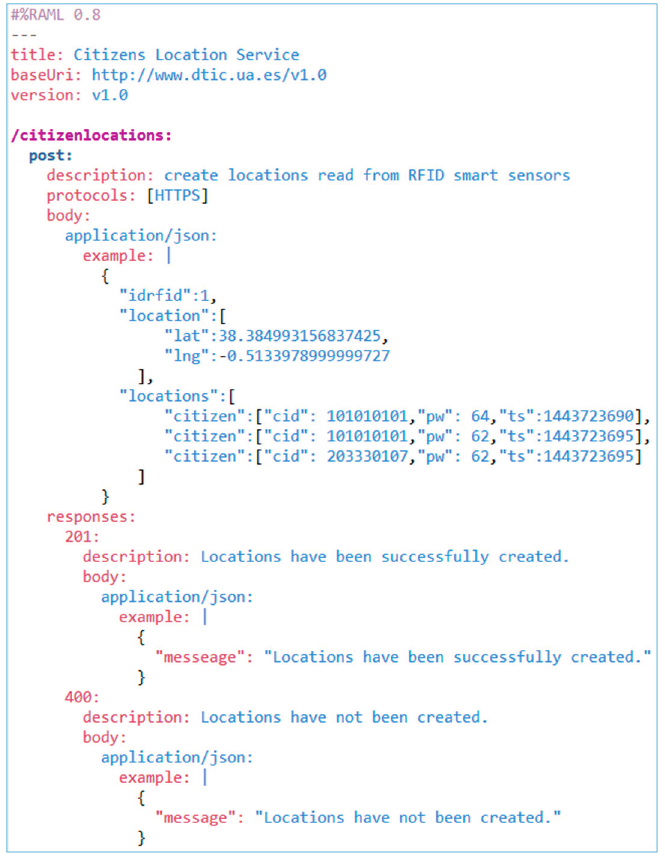
Figure 9. RAML contract of location message acquisition